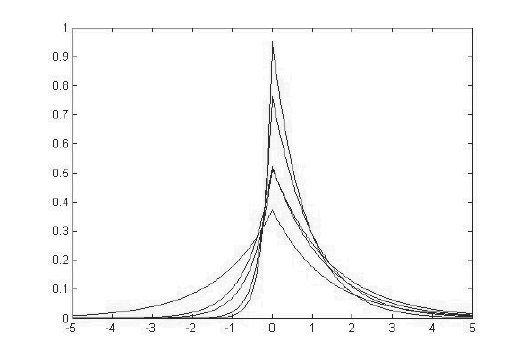
Figure 1 – Approximated Asymmetric Laplace densities, =1  and  =0,1,1.5,3,4 and  = 0.8,1.8,2,5,8 which corresponds to  = 1,0.69,0.60,0.53,0.51.